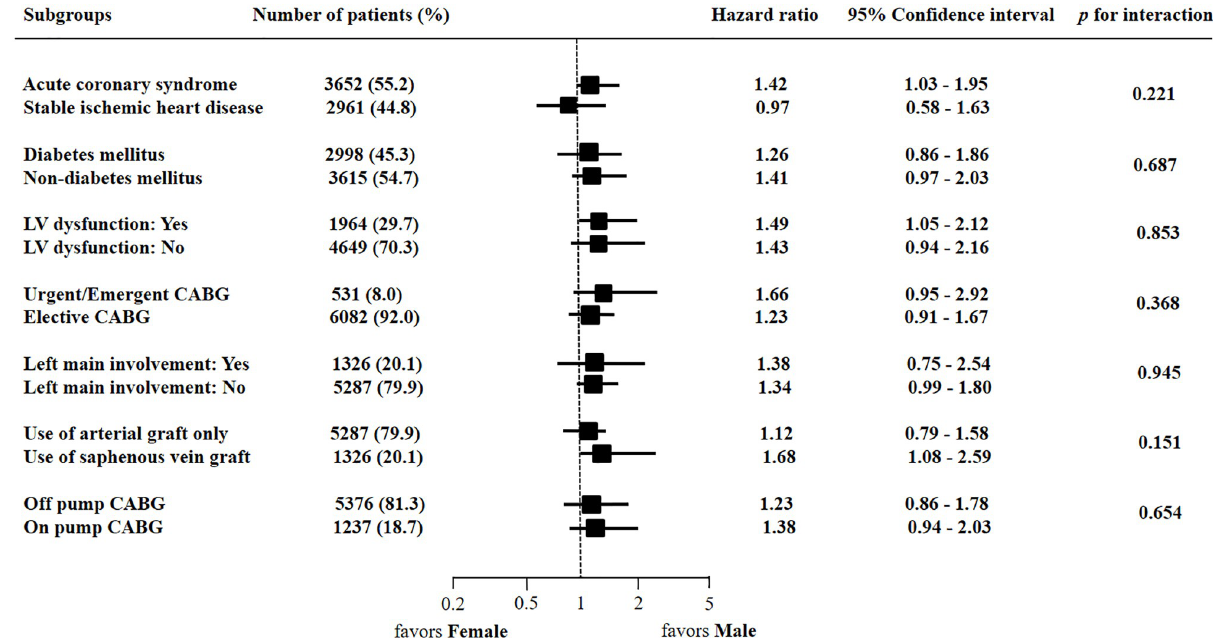
Fig 4. Comparative unadjusted hazard ratios of cardiovascular death or MI at 5 years for various subgroups. CABG = coronary artery bypass grafting, LV = left ventricular.